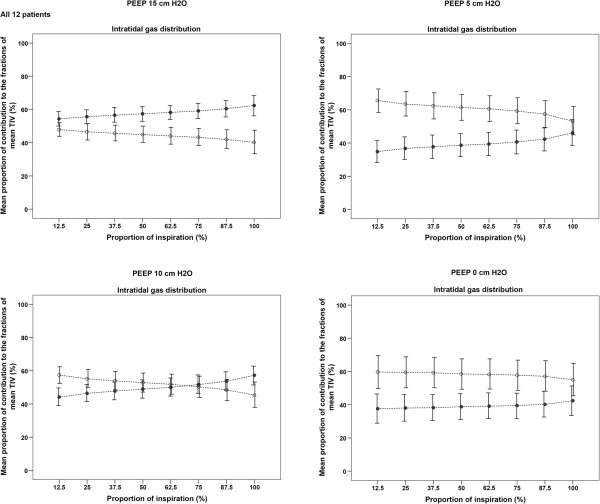
Intratidal gas distribution at varying positive end-expiratory pressure (PEEP) levels. Mean intratidal gas distribution in eight iso-volume steps during four PEEP levels during the decremental PEEP trial. Decreasing the PEEP level resulted in a higher overall gas distribution to the non-dependent region and, subsequently, a lower gas distribution to the dependent region. During the course of inspiration, gas distribution to the non-dependent region decreased whereas it increased to the dependent region. At a PEEP level of 10 cm H2O, during inspiration the lines representing gas distribution to both regions crossed each other. Dashed lines represent the interpolation lines; open circles = non-dependent region; solid circles = dependent region.